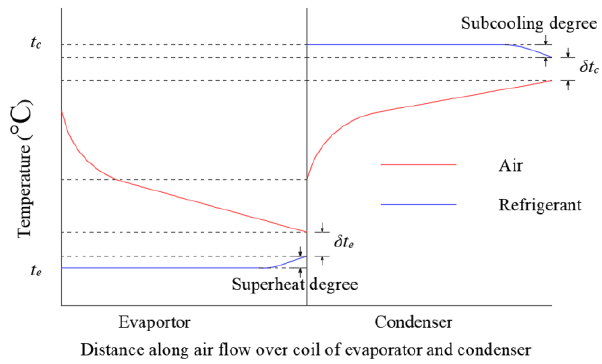
Figure 4. The temperature profile of the air and the refrigerant.